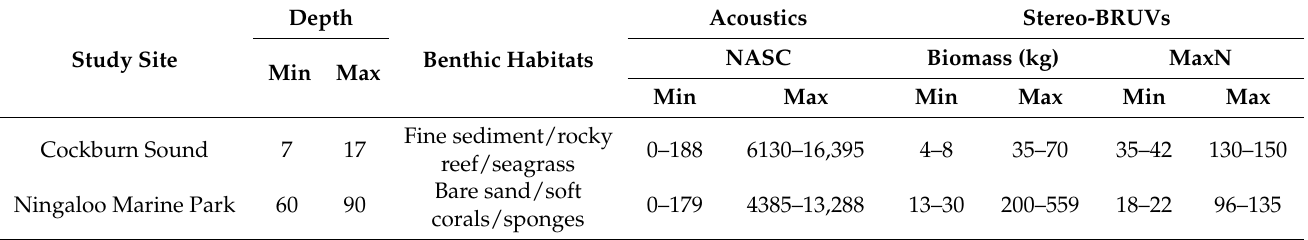
Table 2. Summary of the main variables measured in Cockburn Sound and Ningaloo Marine Park, including acoustic NASC and relative biomass (kg) and abundance (MaxN) from the stereo-BRUVs.